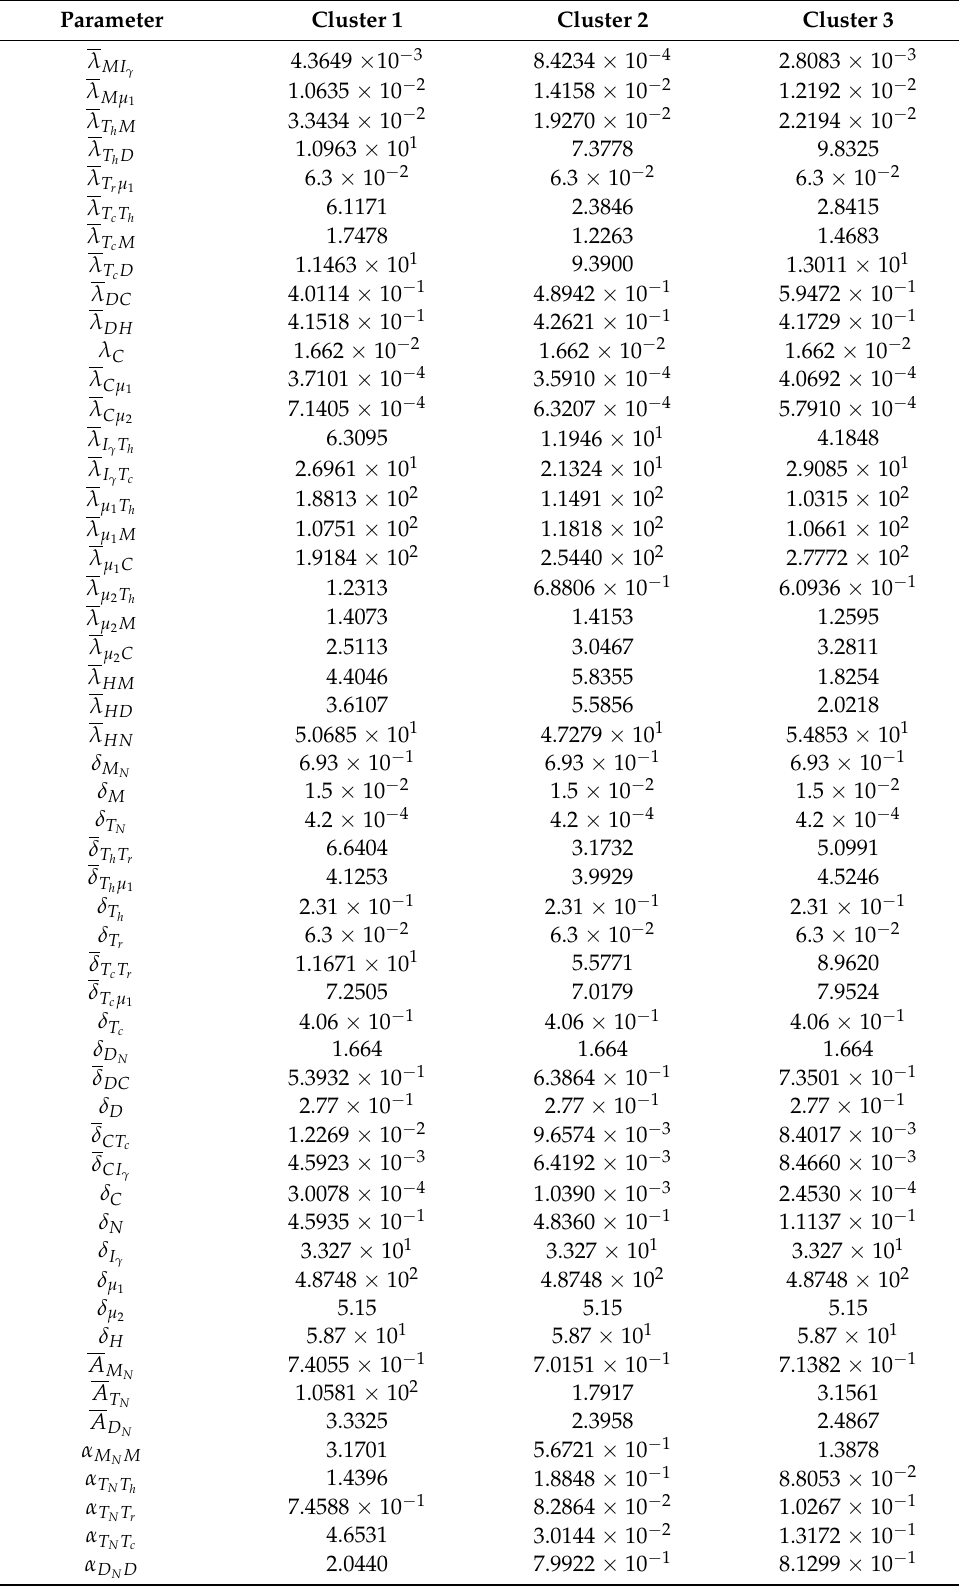
Table A2. Non-dimensional parameter values for each cluster, the sources can be found in the ODE paper